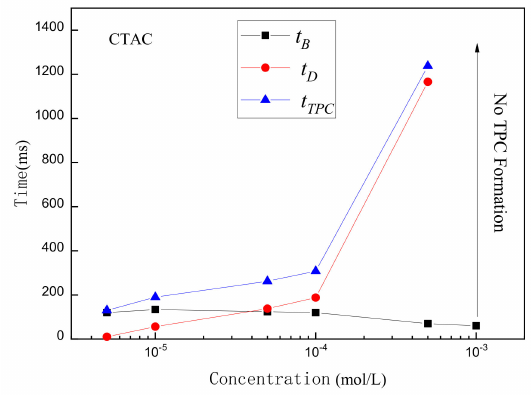
Figure 12. The t TPC , t B , and t D of talc in different CTAC concentrations.